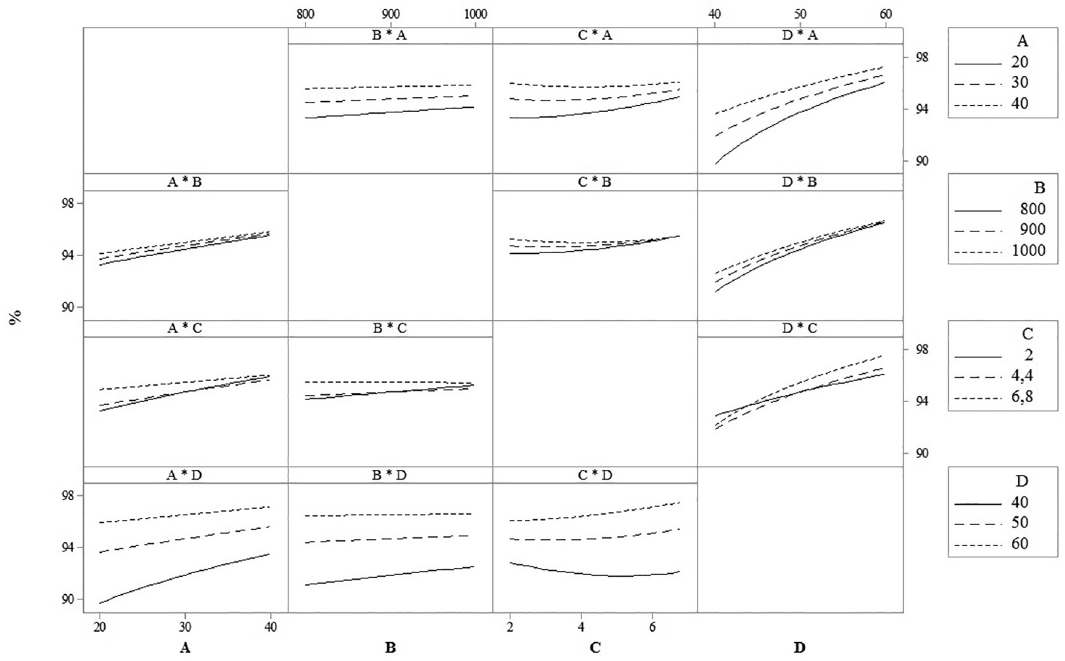
FIGURE 3 - Main effects and interactions plots for the effect of time of dissolution (A, from 20 to 40 minutes), volume f dissolution media (B, from 800 to 1000 mL), pH of dissolution media (C, from 2.o to 6.8), rotation speed (D, from 40 to 60 rpm), and their interactions (AB, AC, AD, BC, BD, and CD) on the amount of acetaminophen dissolved.